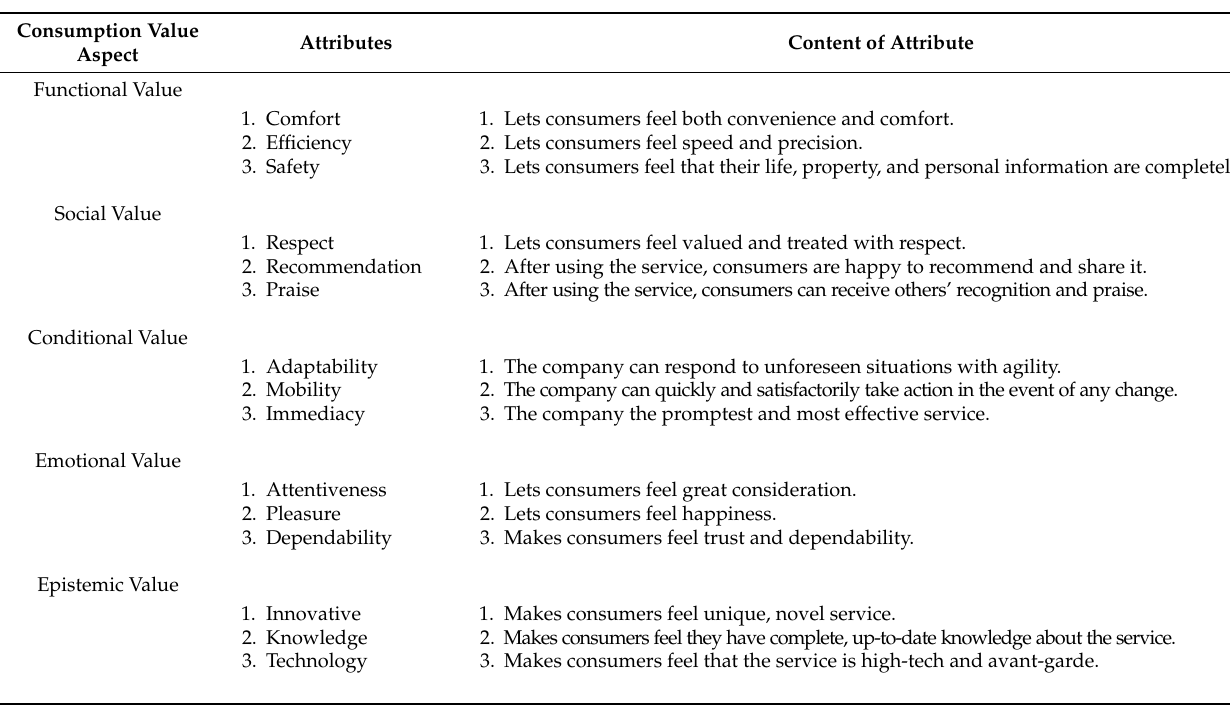
Table 5. Content of CV-SQ